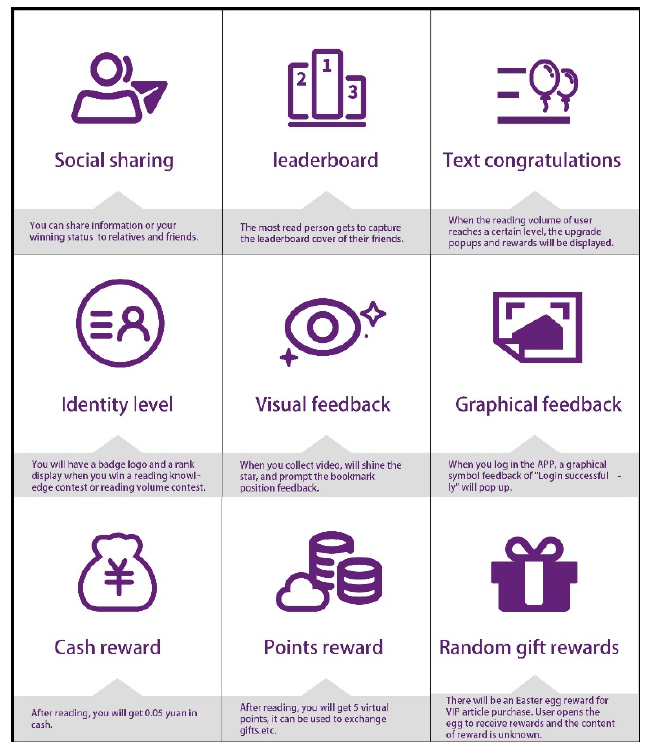
Figure 4. Diagram of gamification elements.